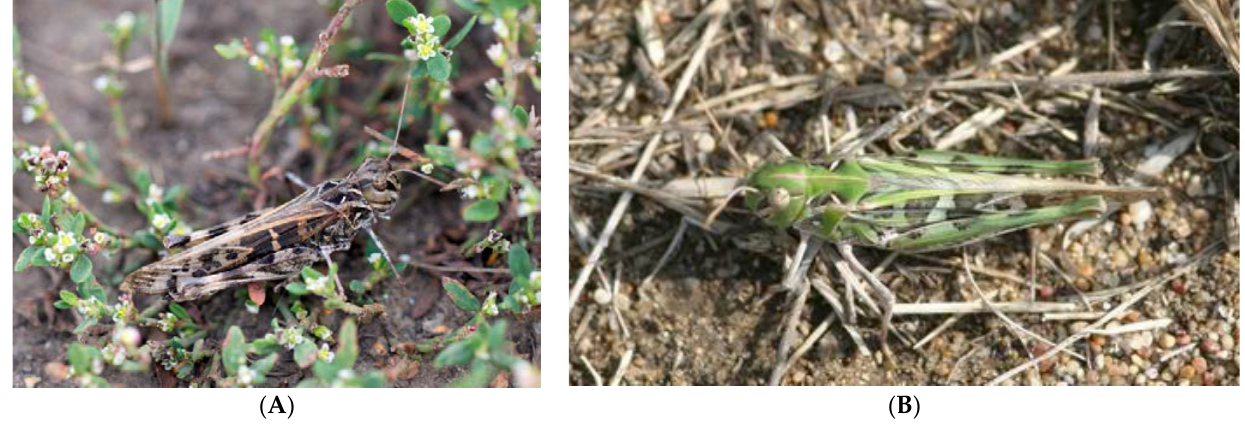
Figure 10. Main color forms of Oedaleus decorus in the Kulunda steppe: ( A )—brown; ( B )—green. The multivariate regression model shows very week non-significant correlations between these parameters: however, the correlation is positive for the brown form (r = 0.214, p = 0.553) and negative for the green one (r = –0.325, p = 0.359) (overall statistics: R 2 = 0.070, MSE = 0.050, Wilks’ lambda = 0.853) (Figure 11).